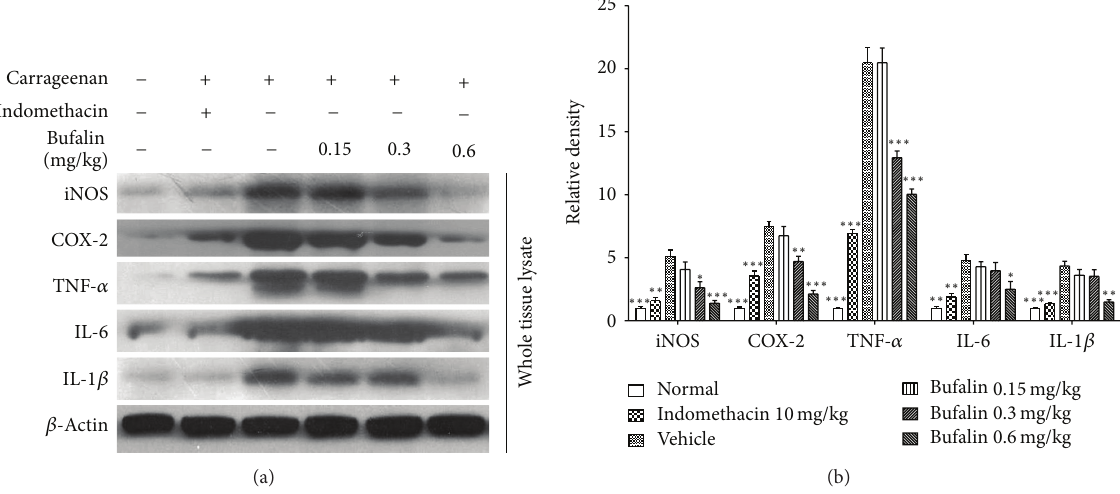
Figure 2: Bufalin inhibited proinflammatory mediators in the carrageenan-induced paw edema model. (a) Effect of bufalin on iNOS, COX-2, TNF- 𝛼 , IL-1 𝛽 , and IL-6 protein expressions in the carrageenan-induced paw edema model as detected using western blot. (b) The protein expression levels were analyzed by Image J.2x software. Data are expressed as the mean ± S.E.M. of 3 determinations, ∗ P < 0.05, ∗∗ P < 0.01, and ∗∗∗ P < 0.001, compared with the vehicle